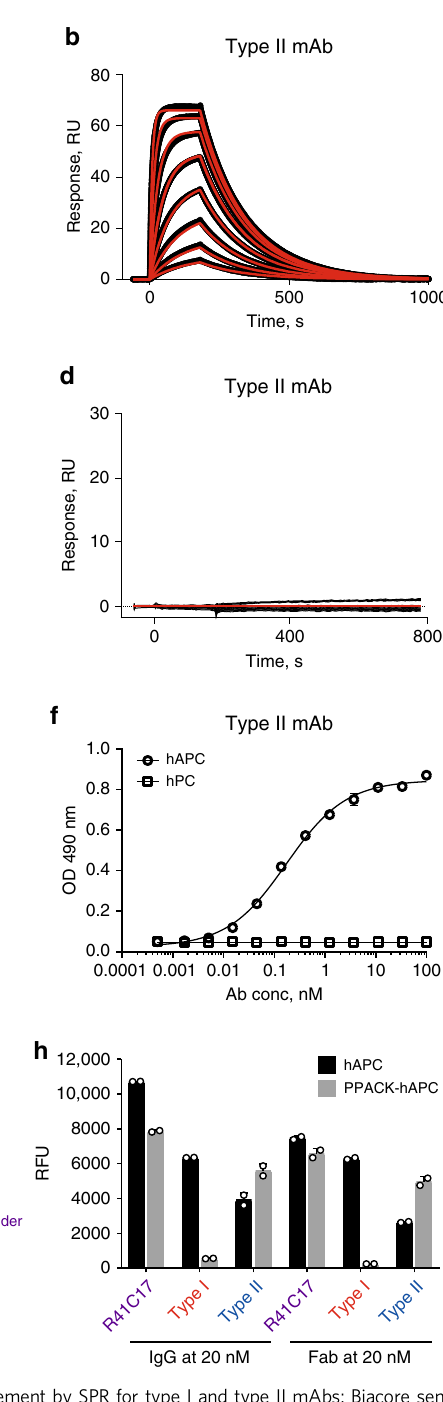
Fig. 1 Antibody characterization using SPR and ELISA. a – d Af fi nity measurement by SPR for type I and type II mAbs: Biacore sensograms showing the association and dissociation curves for antibody binding to hAPC at concentrations of 1.56, 3.125, 6.25, 12.5, 25, 50, 100, and 200nM ( a , b ) or to hPC at concentrations of 1.56, 3.125, 6.25, 12.5, 25, 50, 100, 200, 400, and 1000nM ( c , d ). Black traces represent experimental data, and red traces represent the corresponding fi ts. Type I showed a slower on-rate ( k a , 1.5×10 5 M − 1 s − 1 ) and off-rate ( k d , 1.9×10 − 3 s − 1 ) than type II ( k a , 6.1×10 5 M − 1 s − 1 ; k d , 6.2×10 − 3 s − 1 ). e , f Antibody-binding speci fi city by ELISA for type I mAb ( e ) and type II mAb ( f ) bound to hAPC (circle) or hPC (square). ELISA results are shown as mean± SDs from triplicate wells for each antibody concentration, and experiments were repeated >3 times. g Schematic representation of the binding sites on APC protease domain for type I, type II, and R41C17 mAbs. R41C17, an anti-APC Gla-domain antibody, was used as control. h Type II but not type I bound the complex of PPACK-hAPC. PPACK-hAPC or hAPC was coated onto a MaxiSorp plate at 100ng per well overnight. IgG or Fab at concentrations starting at 20 nM were tested for binding. SPR surface plasmon resonance, ELISA enzyme-linked immunosorbent assay, hAPC human activated protein C, hPC human protein C, RU relative unit, OD490 absorbance at 490nm, PPACK Phe – Pro – Arg – chloromethylketone, RFU relative fl uorescence unit, IgG immunoglobulin G, Fab antigen-binding